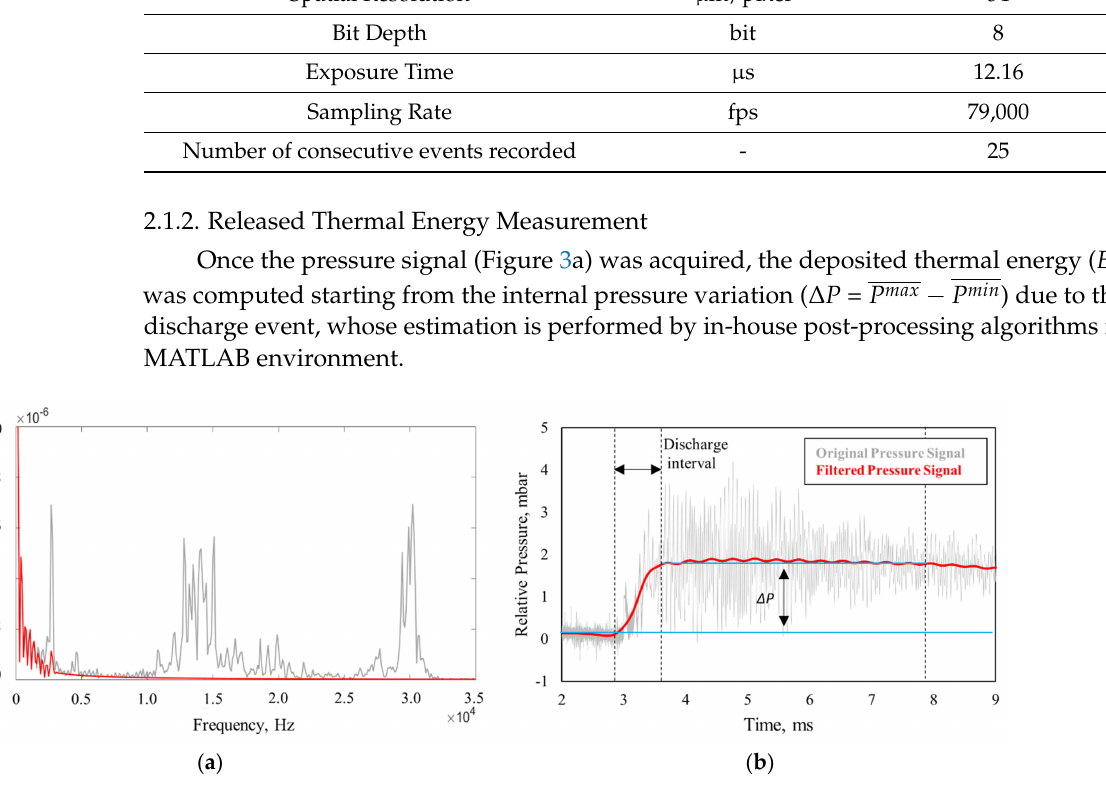
Table 1. High-speed camera settings.